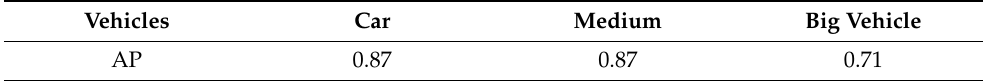
Table 4. Medium average precision results.